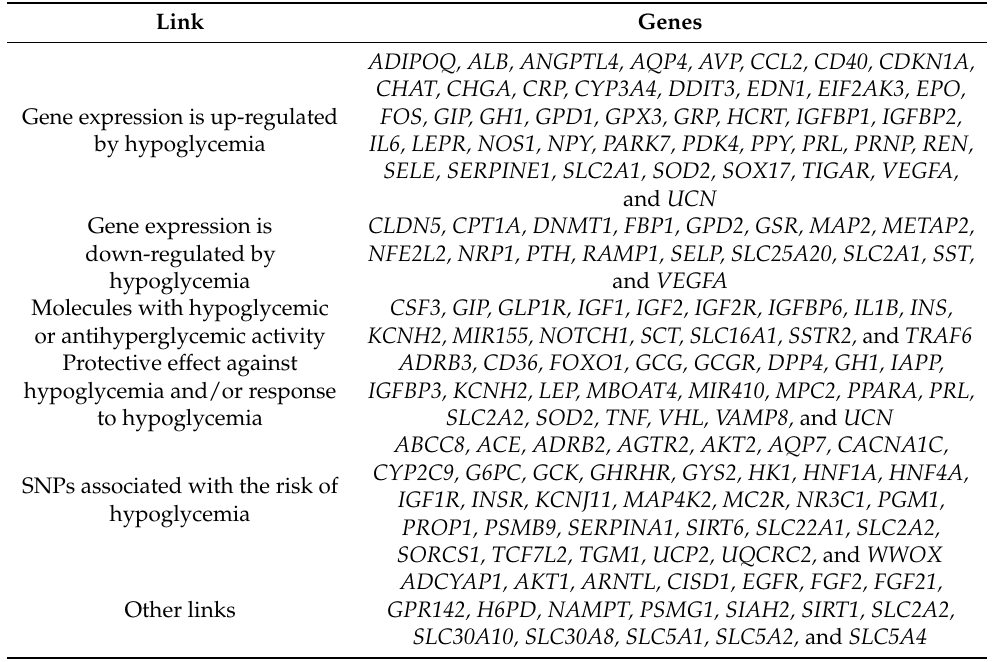
Table 2. The patterns of the links between identified genes and hypoglycemia.